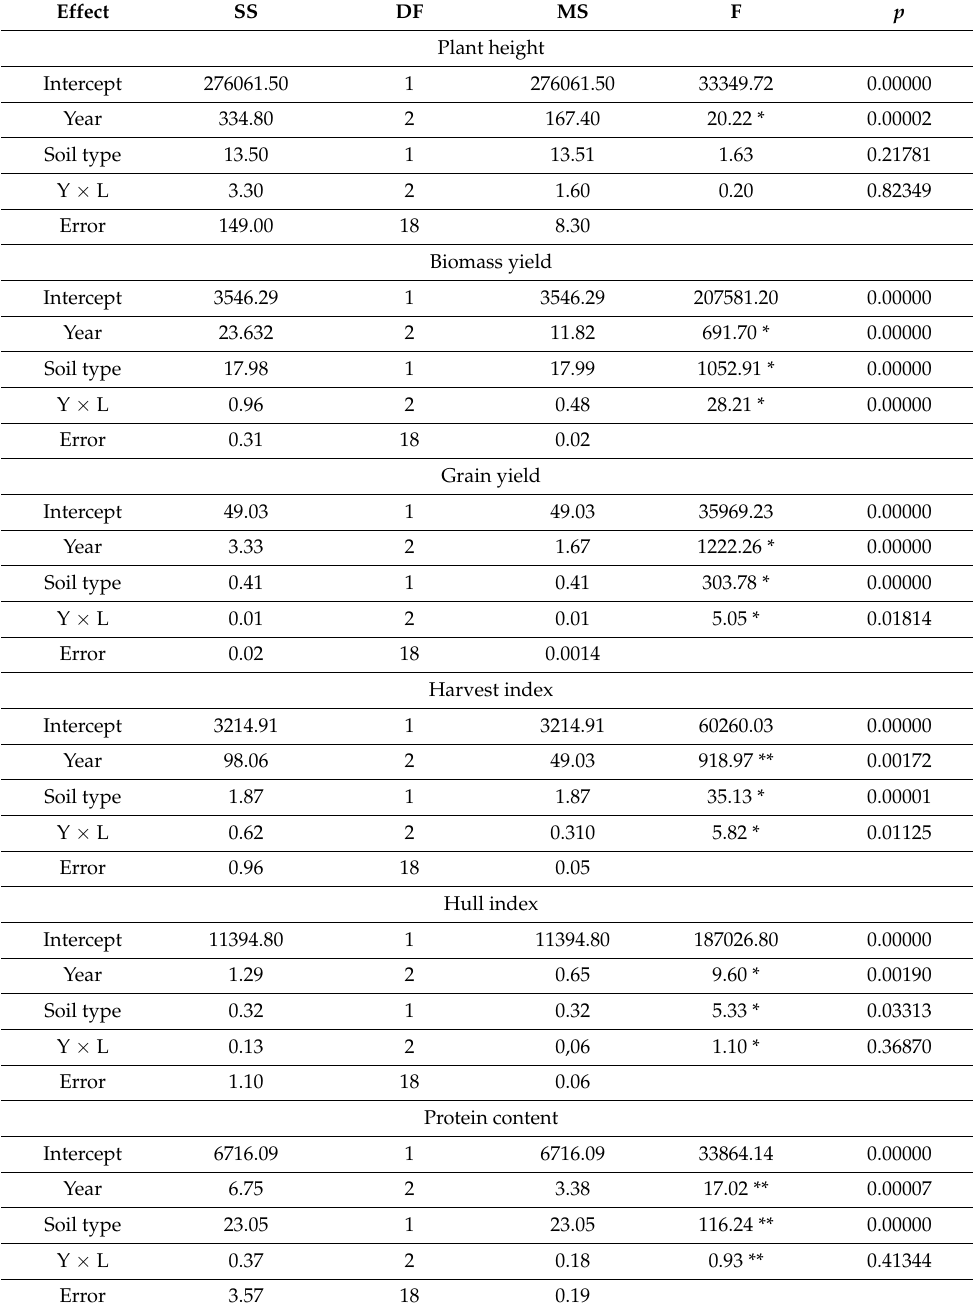
Table 4. Analysis of variance for the tested